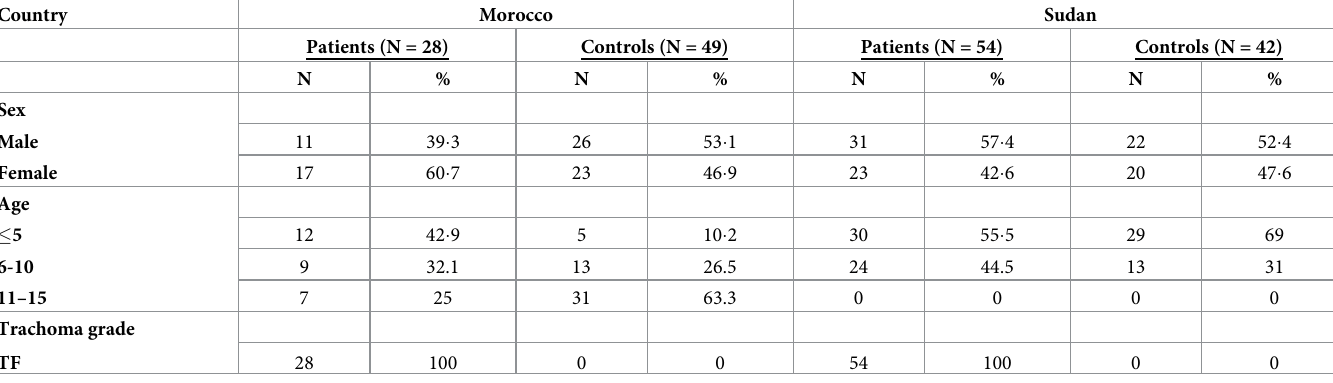
Table 2. Baseline and trachoma grades of study participants in Zagora Province (Morocco) and Al Qadarif (Sudan). Country Morocco Sudan Patients (N =